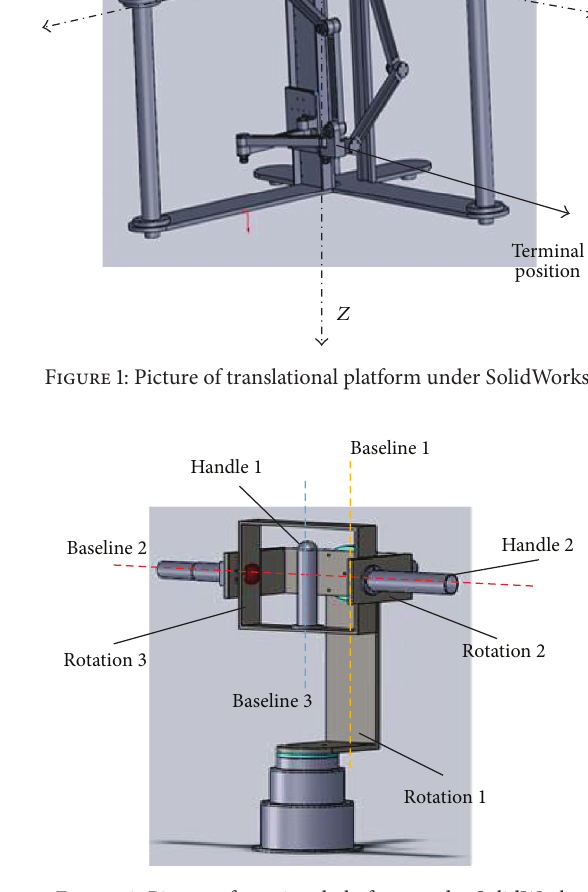
Figure 2: Picture of rotational platform under